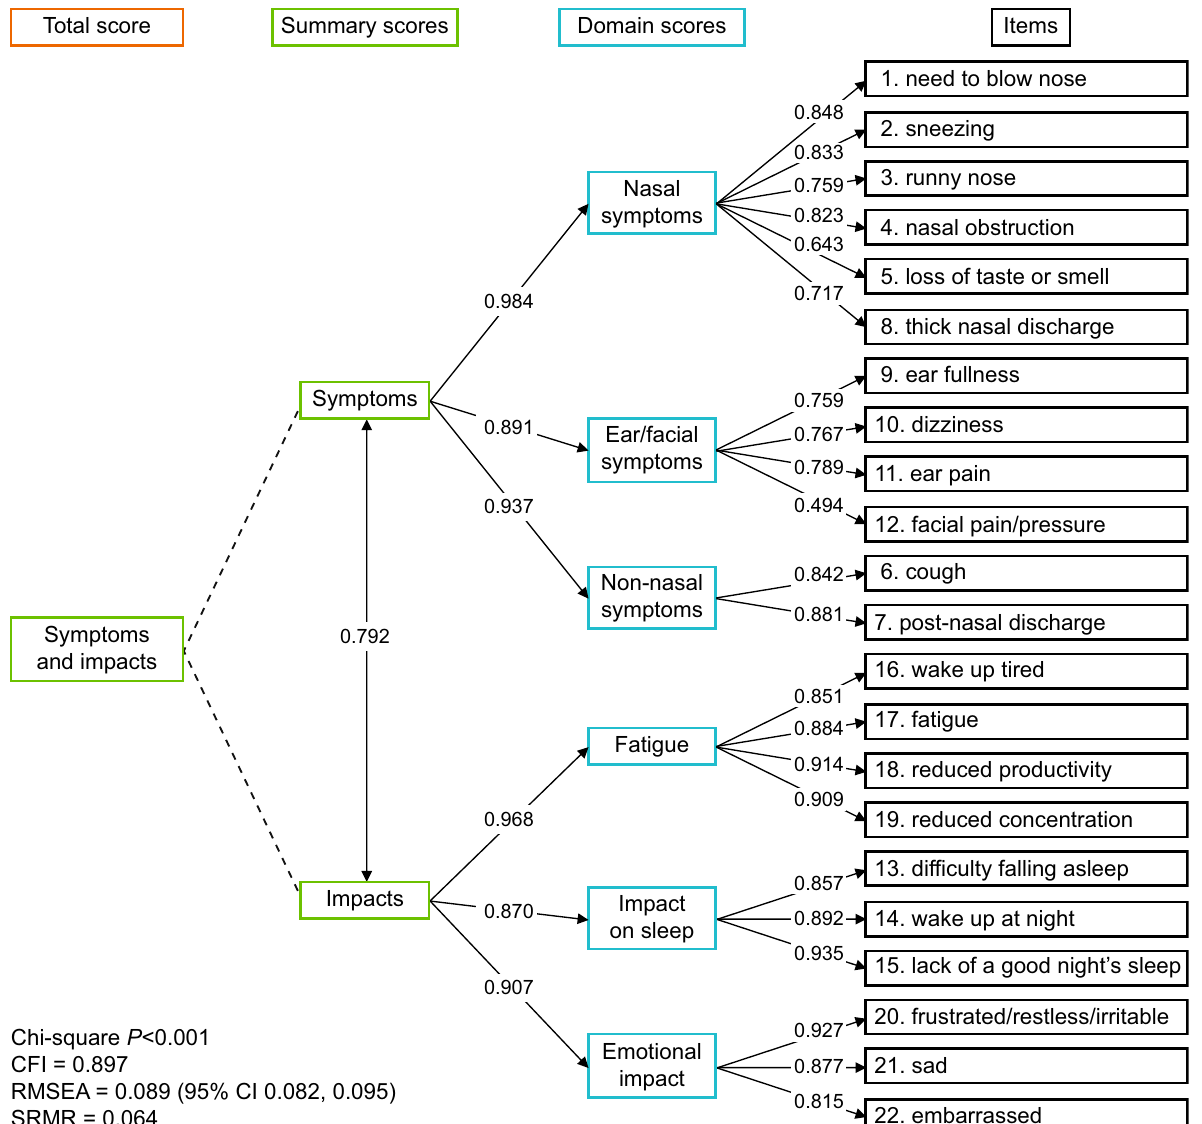
Fig. 1 The six-domain SNOT-22 model with standardized factor loadings. The CFA model, including the standardized factor loadings (numbers on arrows) from each hypothesized domain to the SNOT-22 items and Chi-squared, CFI, RMSEA, and SRMR fit statistics. Standardized factor loadings represent the correlation coefficients between factors. CFA Confirmatory factor analysis, CFI Comparative fit index, RMSEA Root mean square error of approximation, SNOT-22 Sino-nasal outcome test-22, SRMR Standardized root mean square